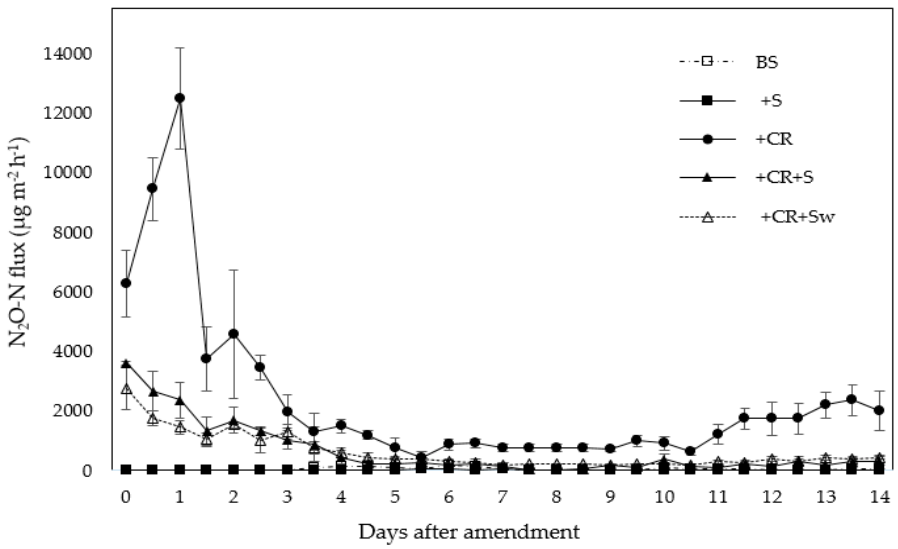
Figure 1. Daily N 2 O flux (mean ± SE; n = 4) from soil microcosms with different treatments: BS = unamended soil, +S = wheat straw, +CR = broccoli crop residue, +CR+S = broccoli straw and +CR+Sw = broccoli washed straw.